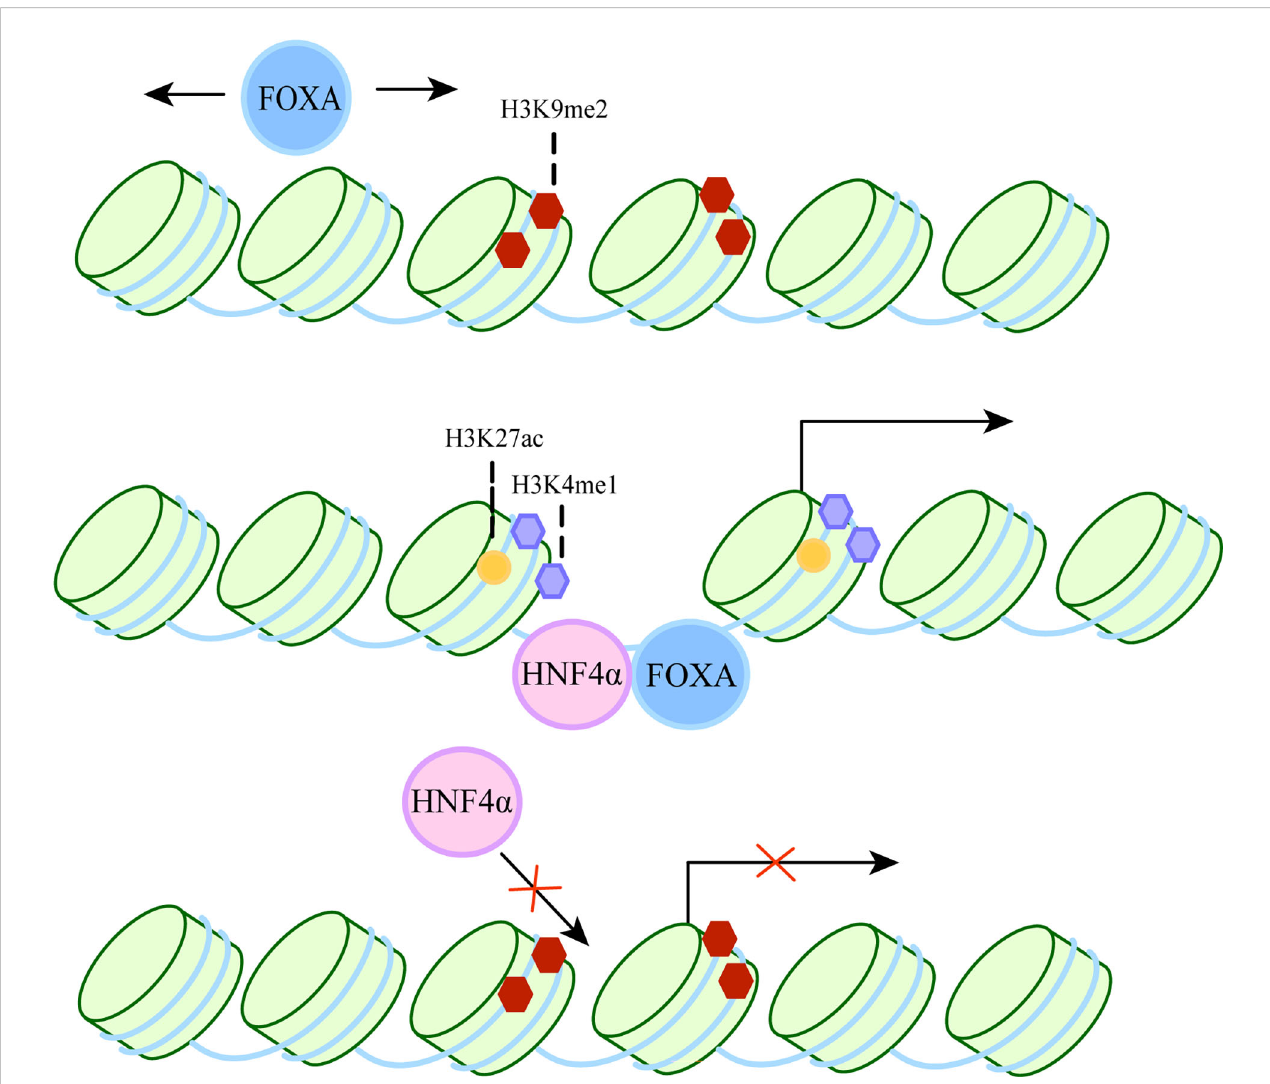
FIGURE 1 The dual role of FOXA as a pioneer and settler transcription factor. FOXA can bind target DNA sequences around nucleosomes in condensed chromatin. The fi rst step, FOXA scans the chromatin laterally (12) and uses short anchoring a -helix structures to identify DNA motifs (13). The second step, since the crystal structure of the DBD of FOXA is highly similar to the ligand histone, they both use a “ winged helix ” structure to bind to DNA along the long axis of DNA (10, 14). In some cases, FoxA can replace linker histones (15). Then, induction of nucleosome repositioning and recruitment of co-transcription factors such as hepatocyte nuclear factor 4 a (HNF4 a ), followed by high chromatin accessibility and aggregation of methylated H3K4 (H3K4me1) and acetylated H3K27 (H3K27ac). The resulting permissive chromatin state promotes transcriptional initiation, as FOXA cooperates with HNF4 a to activate liver-speci fi c genes